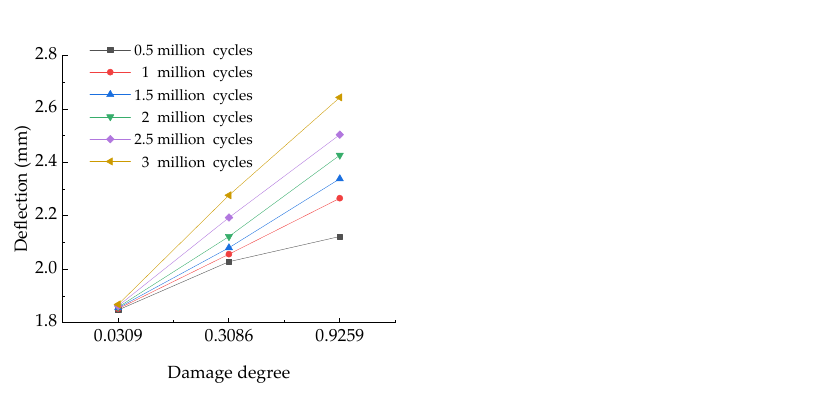
Figure 26. The relationship between the mid-span deflection and damage degree.